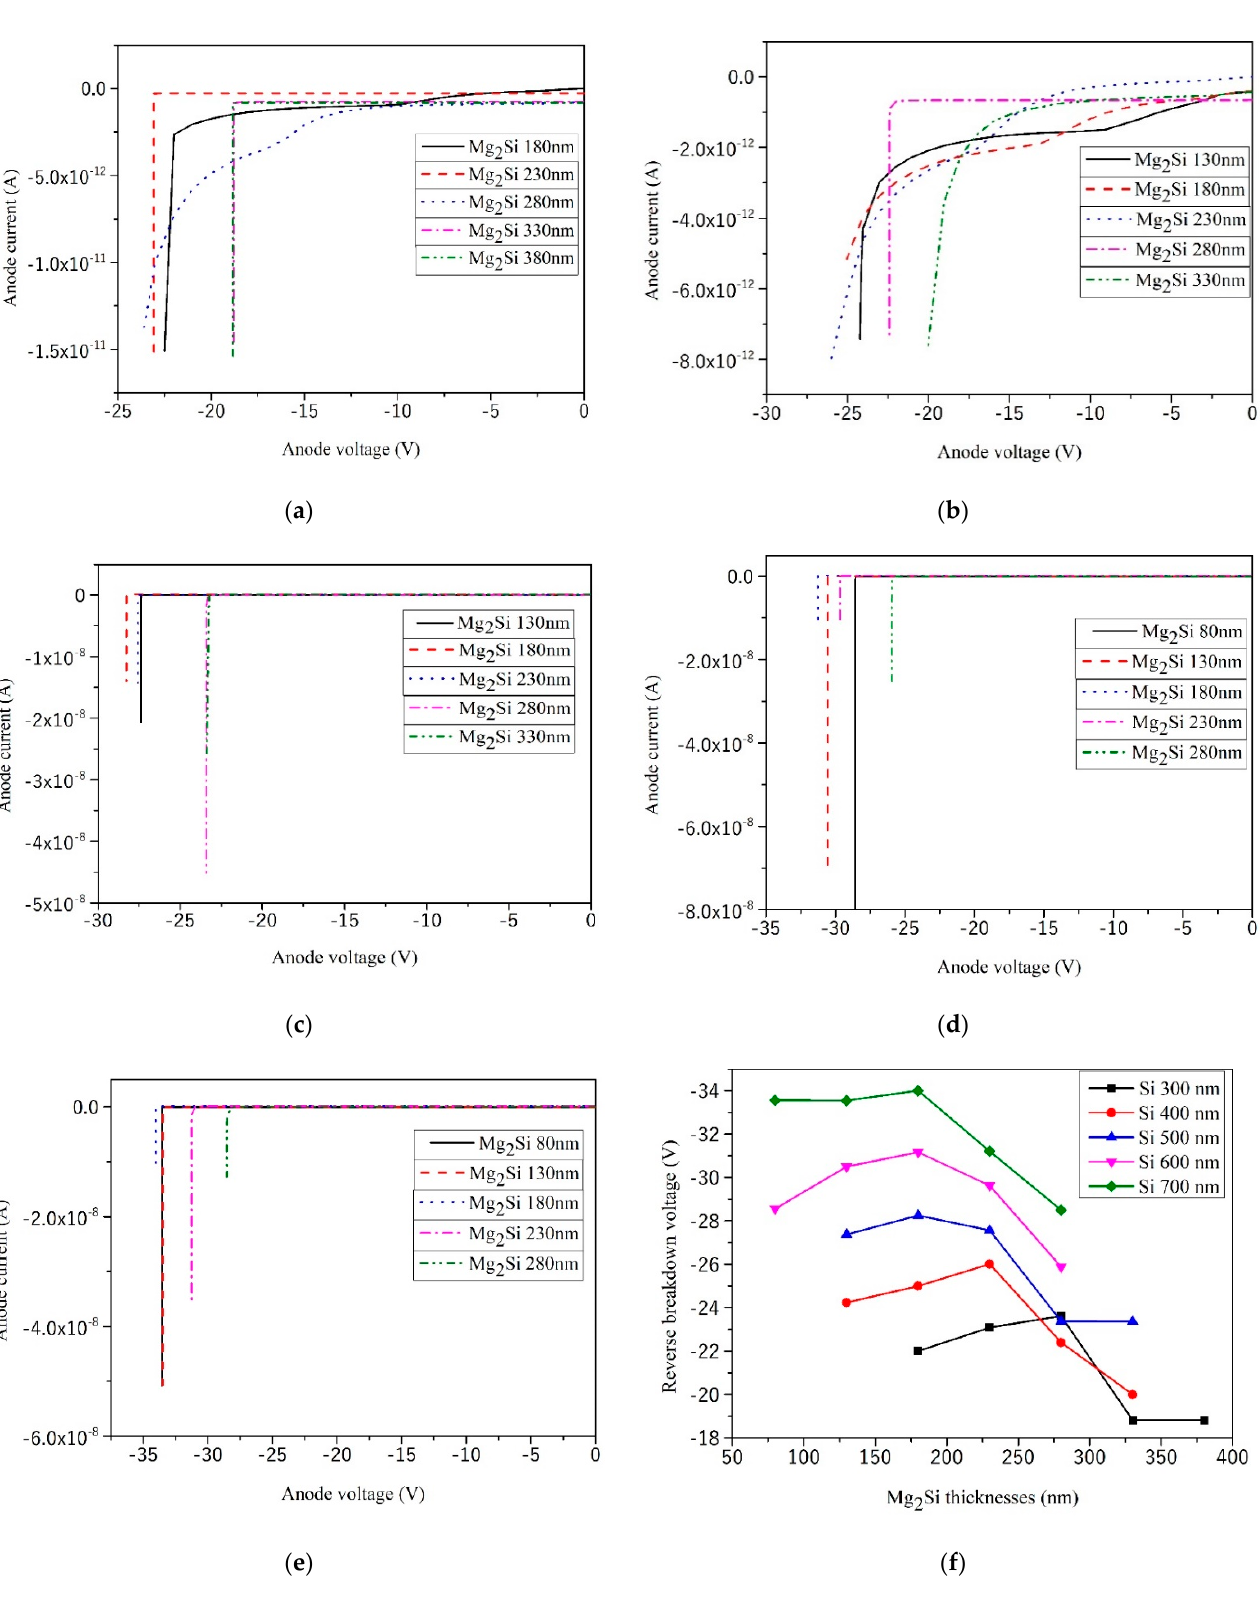
Figure 4. The reverse I–V curves of the heterojunction PD with different Mg 2 Si thicknesses under the condition of 300 nm, 400 nm, 500 nm, 600 nm, and 700 nm thicknesses of Si. ( a ) Si-300 nm; ( b ) Si-400 nm; ( c ) Si-500 nm; ( d ) Si-600 nm; ( e ) Si-700 nm; ( f ) The effect of thicknesses on the reverse breakdown voltage.